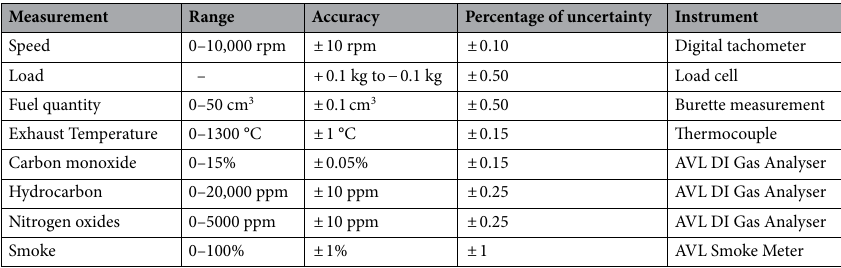
Table 5. Experimentation critical instrumental parameters and its uncertainty.